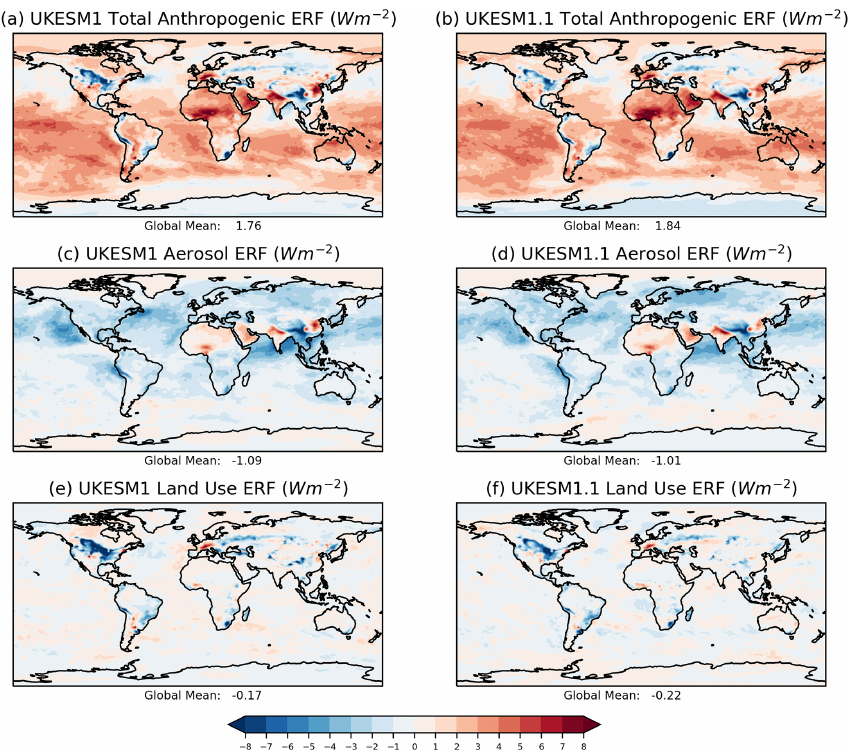
Figure 17. Comparison of the anthropogenic effective radiative forcing (ERF) in (a, c, e) UKESM1 and (b, d, f) UKESM1.1. (a, b) The total anthropogenic ERF, (c, d) aerosol ERF and (e, f) land use change ERF. The ERFs are calculated for the year 2014 relative to an 1850 preindustrial control, following Pincus et al.